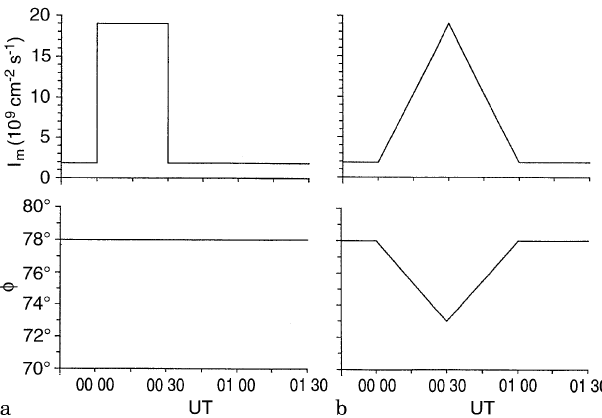
Fig. 2a, b. Time variations of the precipitating 0.23-keV electron flux intensity (top) and geomagnetic latitude of the precipitation maximum (bottom) in a the fixed cusp position ( left - hand plots ) and b the moving ( rigt - hand